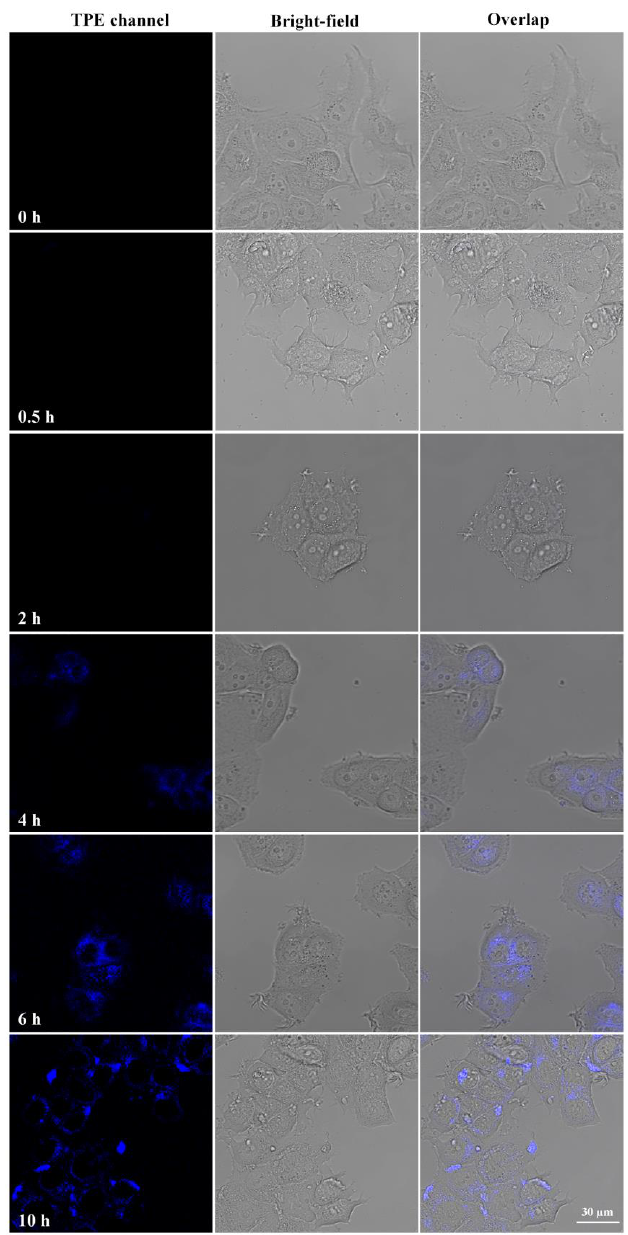
Figure 6. The confocal fluorescence images of MCF-7 cells incubated with the YFNP for different reaction times (0 – 10 h). Curcumin was then introduced to inhibit the expression of intracellular miR-21 to monitor the dynamic expression of miR-21 (Figure 7). A decreased blue fluorescence sig- nal was observed for MCF-7 cells treated with curcumin as compared to the cells treated